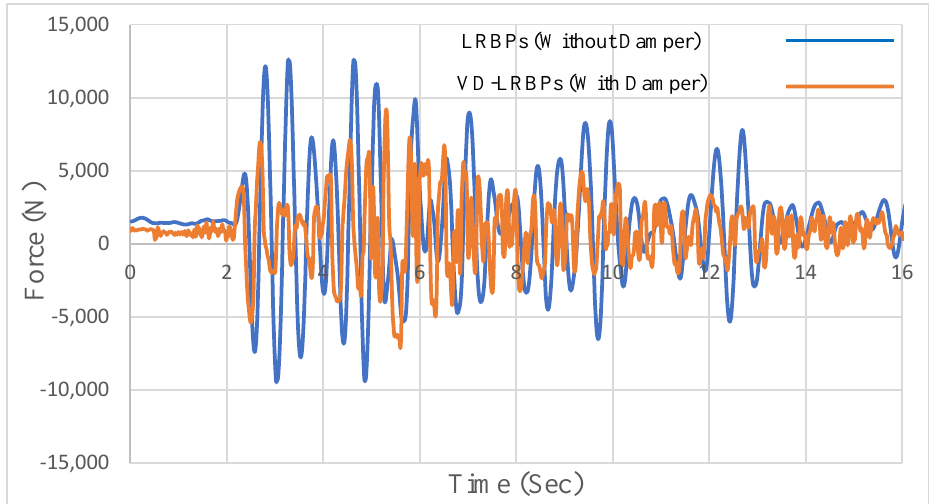
Figure 21. Force histories that pier 1 experiences under the Tabas earthquake.